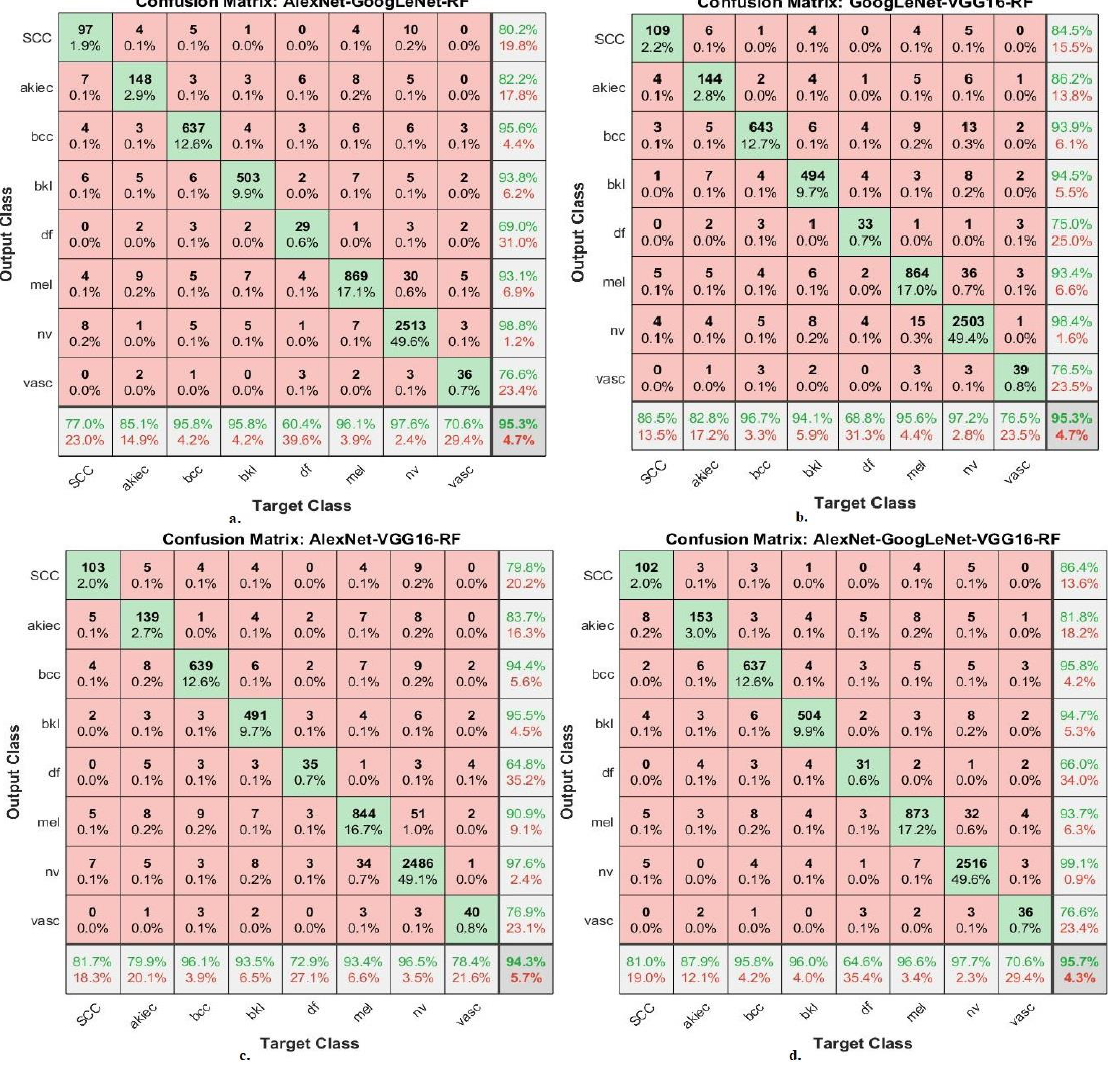
Figure 16. Confusion matrix for displaying performance results of CNN-RF hybrid models based on the fused CNN models for early diagnosis and discrimination of skin cancer and other skin lesions ( a ) AlexNet-GoogLeNet-RF ( b ) GoogLeNet-VGG16-RF ( c ) AlexNet-VGG16-RF ( d ) AlexNet-GoogLeNet-VGG16-RF.